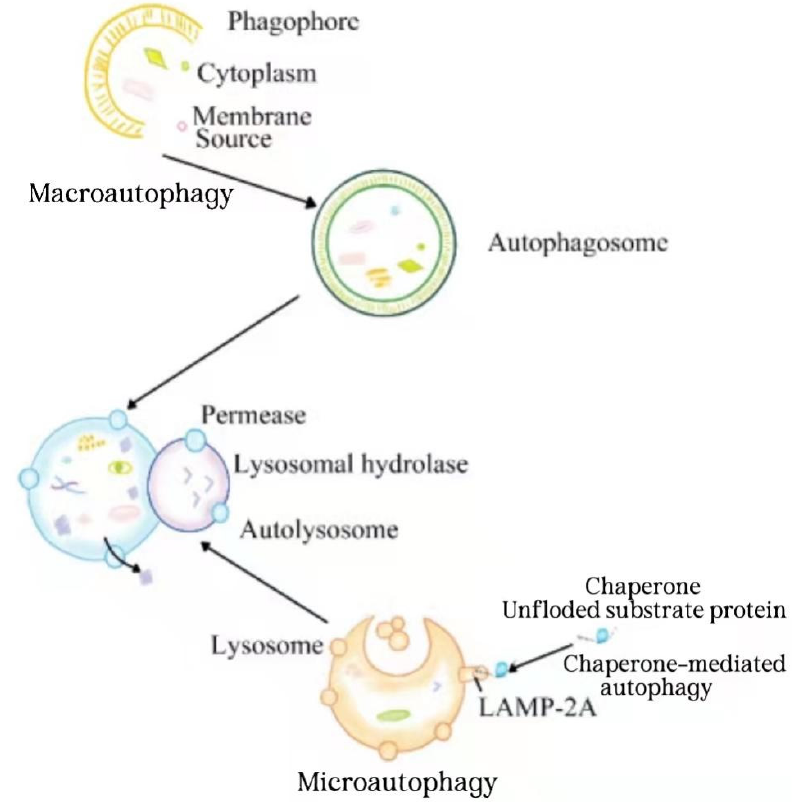
Figure 1. Process diagram of macroautophagy, microautophagy, and chaperone-mediated autoph- agy.